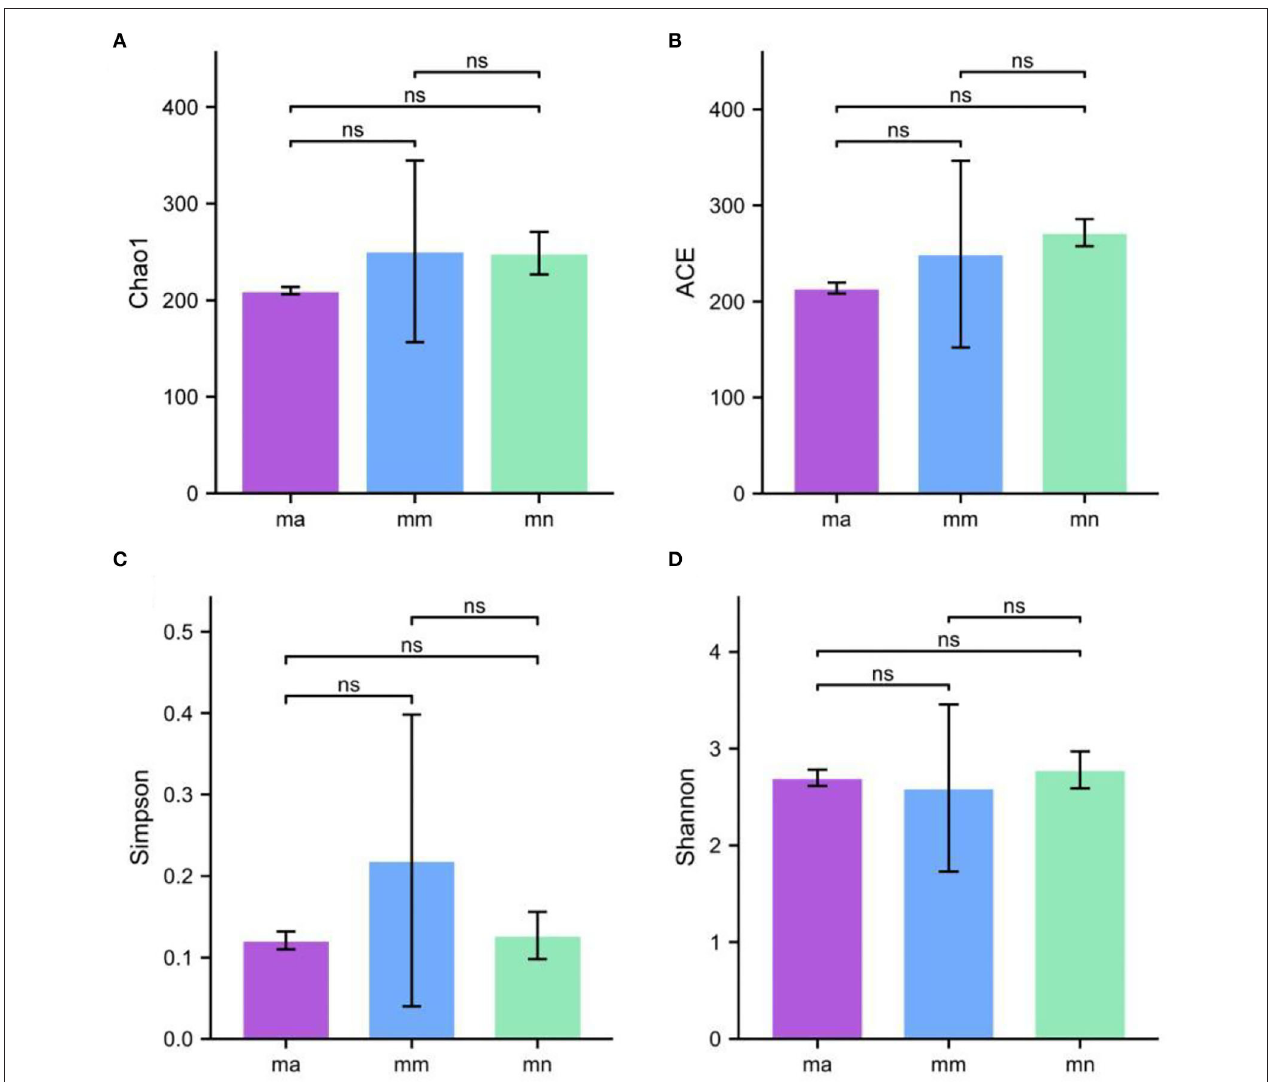
FIGURE 4 | Effect of QWBZP crude polysaccharide on the alpha diversity index of mice intestinal mucosal bacteria. (A) Chao1. (B) ACE. (C) Simpson. (D)